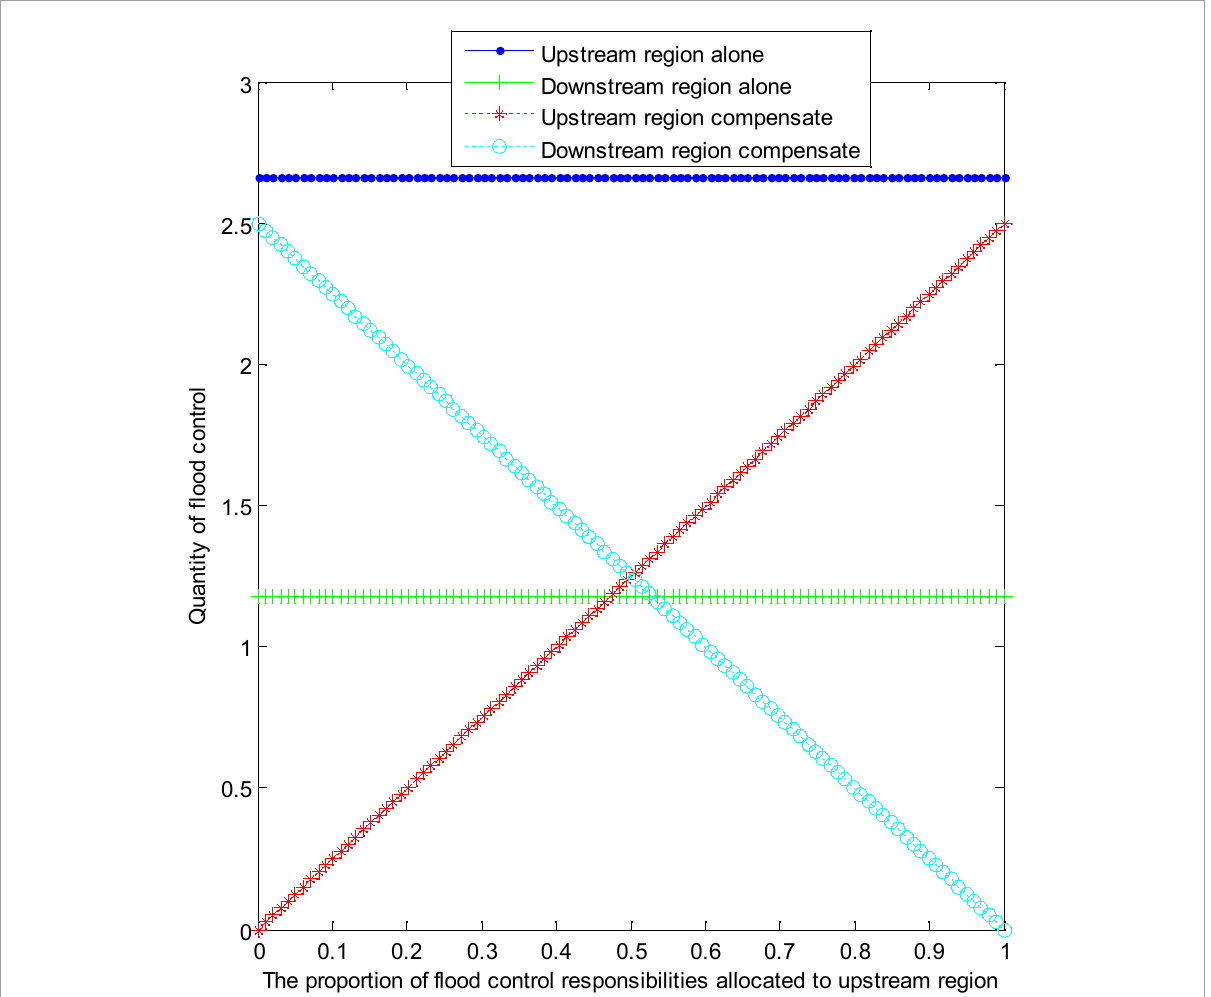
FIGURE4 The impact of allocation ratio on flood